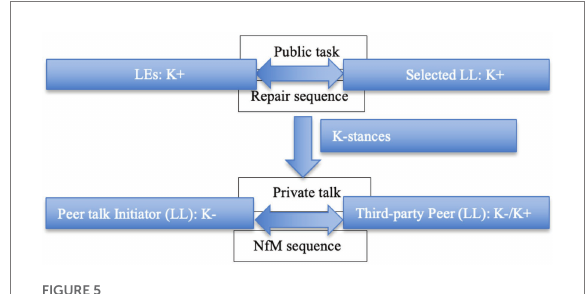
FIGURE 5 Relevance of the public repair sequence for private peer